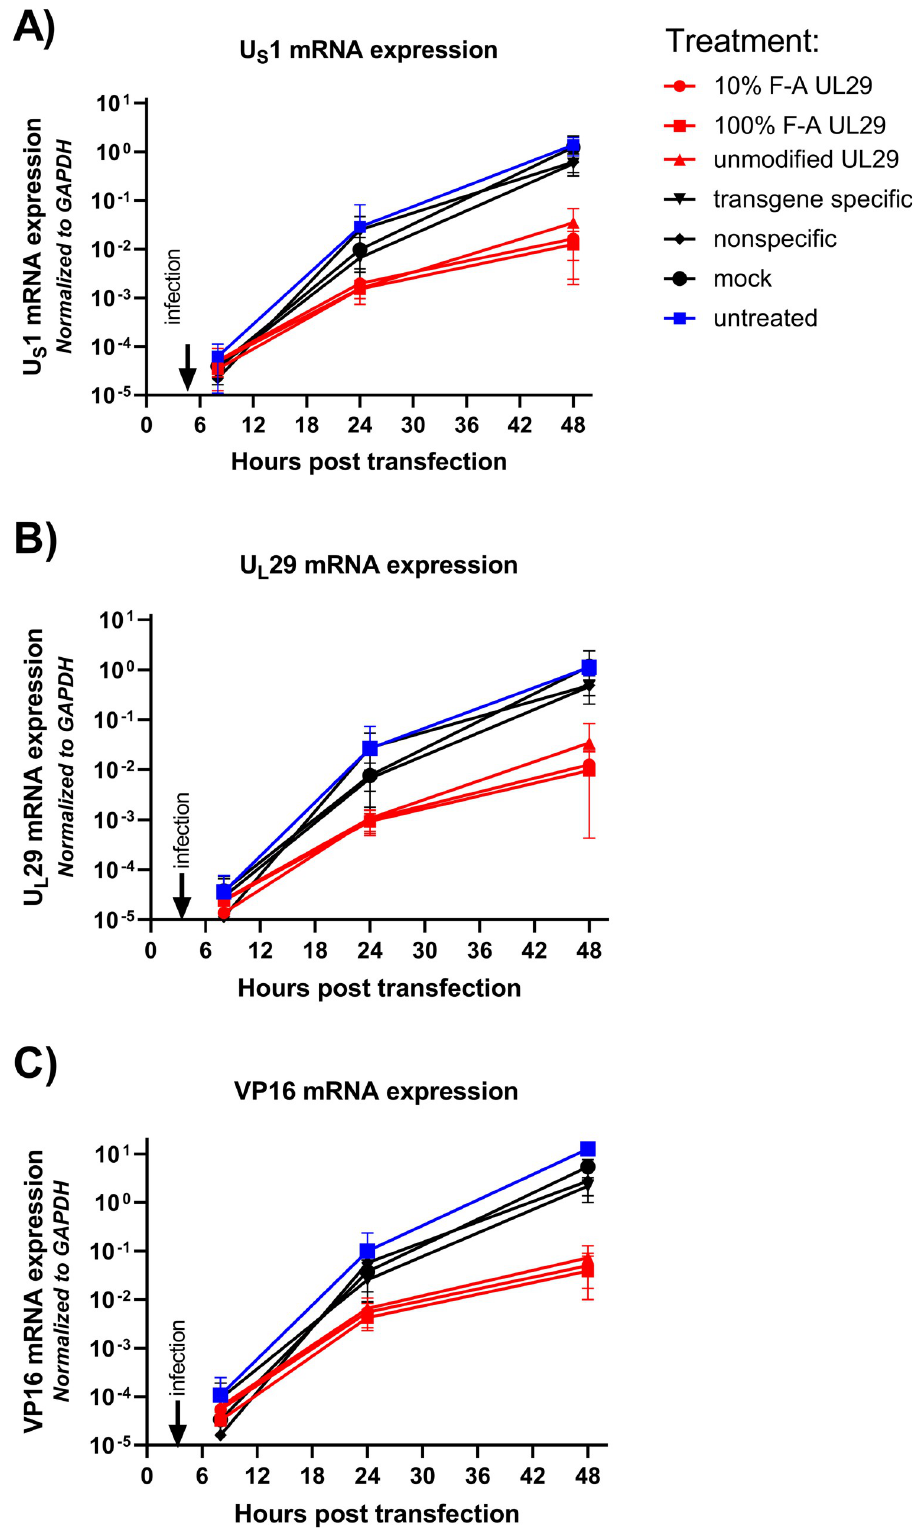
Fig 2. Kinetics of viral mRNA expression during antiviral RNAi treatment. HSV-1 infected HCE cells were transfected with the indicated siRNAs or controls at 50 nM in 96-well plates, and infected with 1000 pfu of